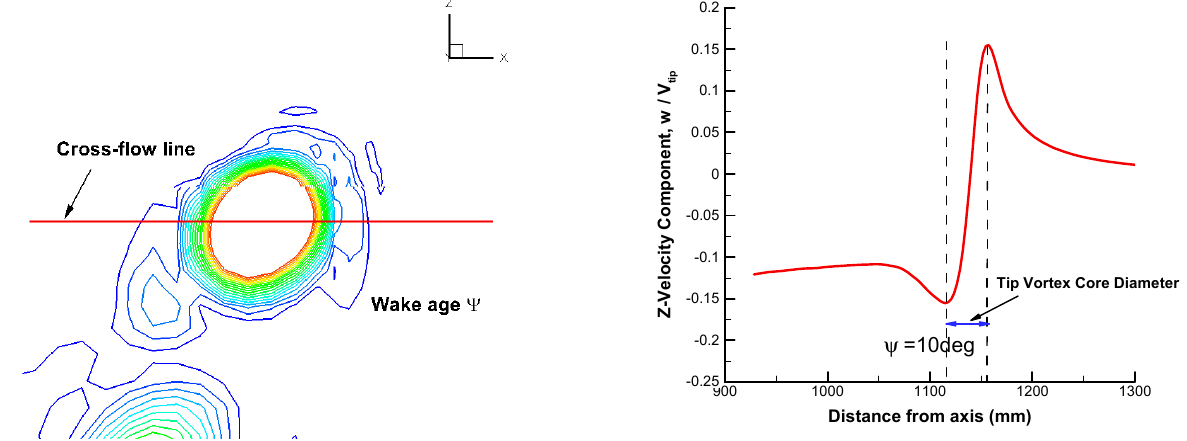
Figure 9. Comparison of vorticity distributions on four radial sections. ( a ) ψ = 0 deg, ( b ) ψ = 45 deg, ( c ) ψ = 90 deg, ( d ) ψ = 135 deg.